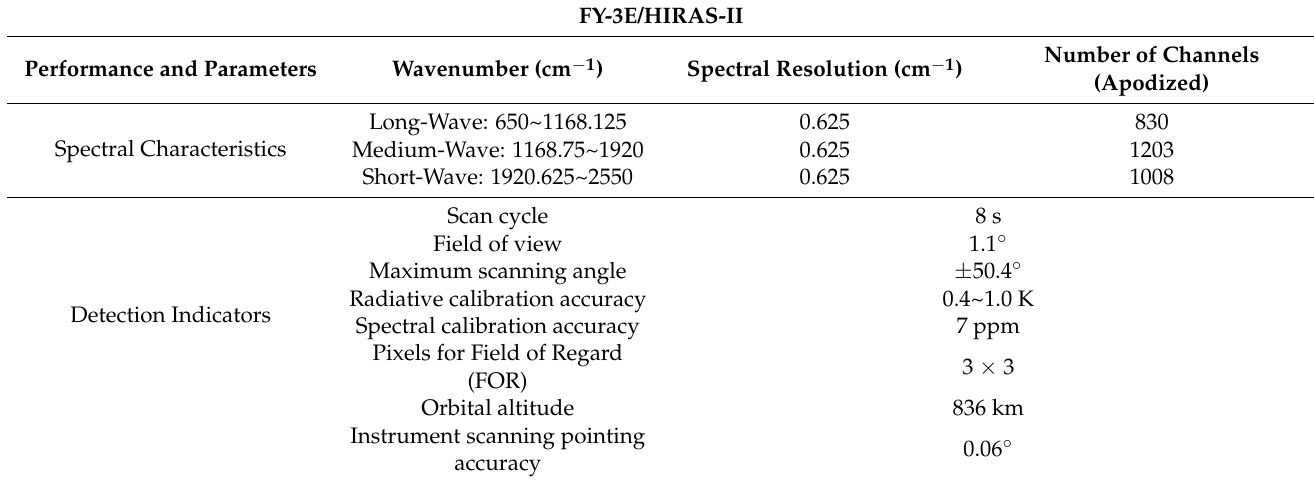
Table 1. FY-3E/HIRAS-II spectral characteristics and detection